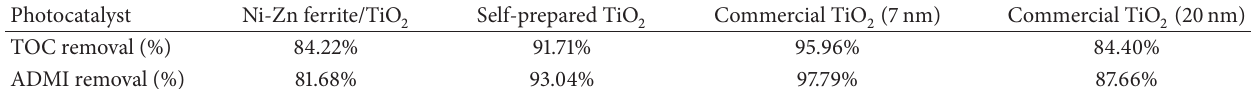
Table 4: Ultimate TOC and ADMI removal % of various TiO 2 (COD = 100 ppm, dosage = 5 g) under UVA irradiation ( 𝐼